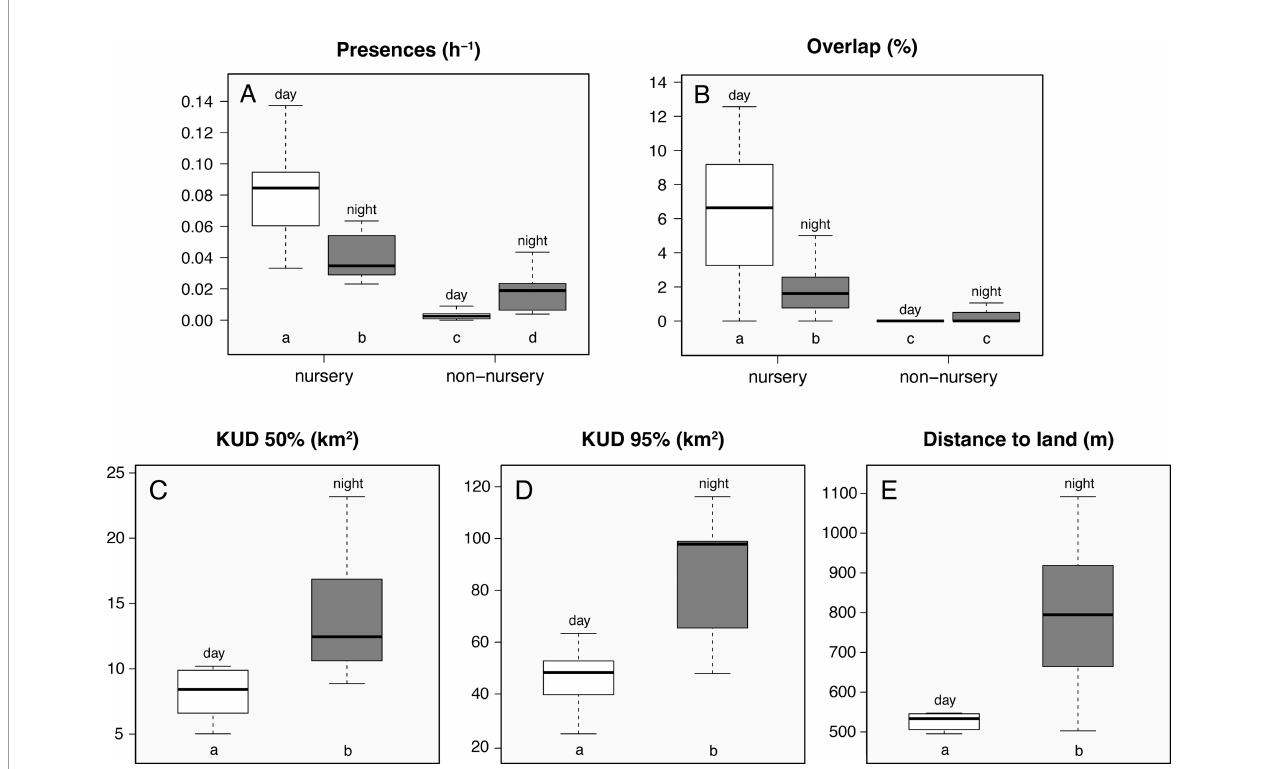
FIGURE 8 | Acoustic detection frequency of smooth hammerhead shark ( Sphyrna zygaena ) (detections h-1; A ), overlap (%; B ), distance to nearest land surface (m; C ), core activity (km 2 ; D ), and home range areas (km 2 ; E ) estimated for each diel phase. Boxes ’ upper and lower limits represent the 75th and 25th quartiles, horizontal lines represent medians, and whiskers represent values within 1.5 interquartile ranges; outliers were removed in order to simplify visual interpretation; lowercase letters below the boxes represent signi fi cance groupings after a pairwise comparison (using Bonferroni correction) where groups sharing the same letter are not signi fi cantly different at p < 0.05.